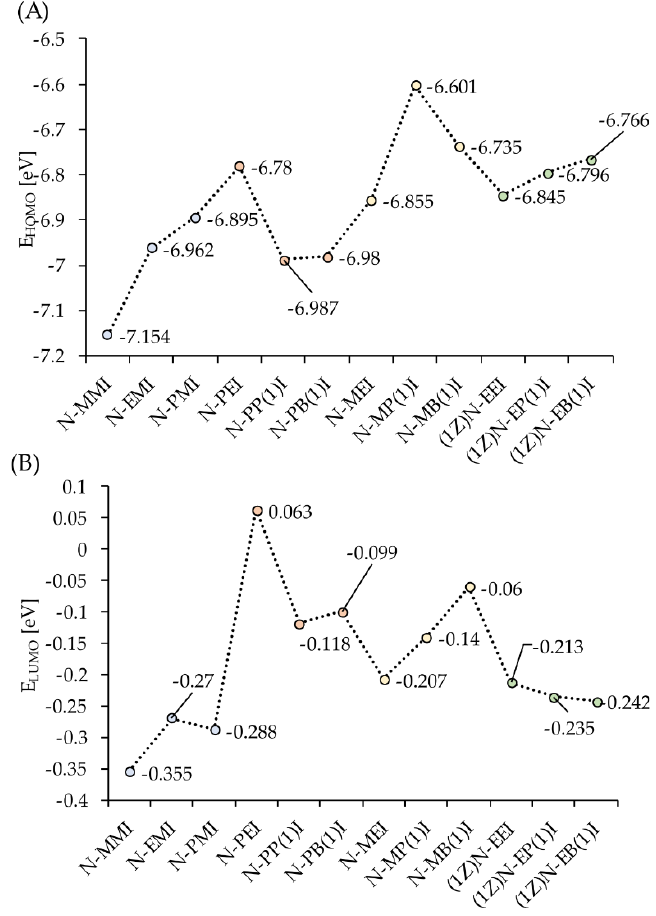
Figure 4. E HOMO ( A ) and E LUMO ( B ) of the investigated Schiff bases determined in the aqueous